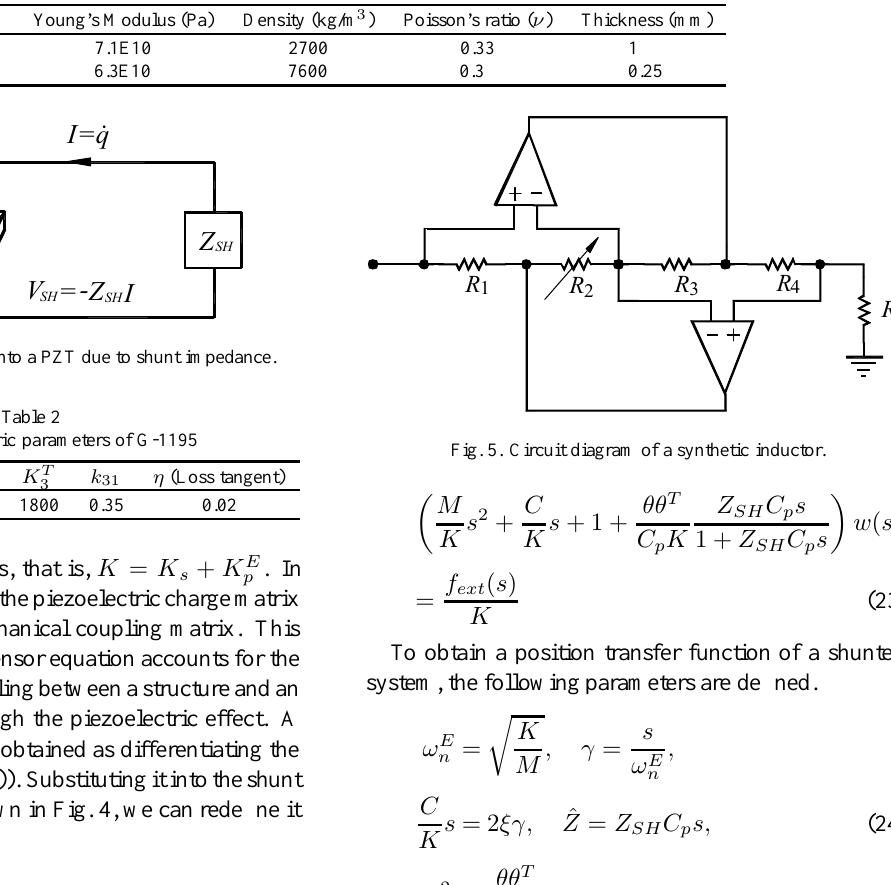
Table 1 Physical and geometrical properties of the beam and piezoceramic